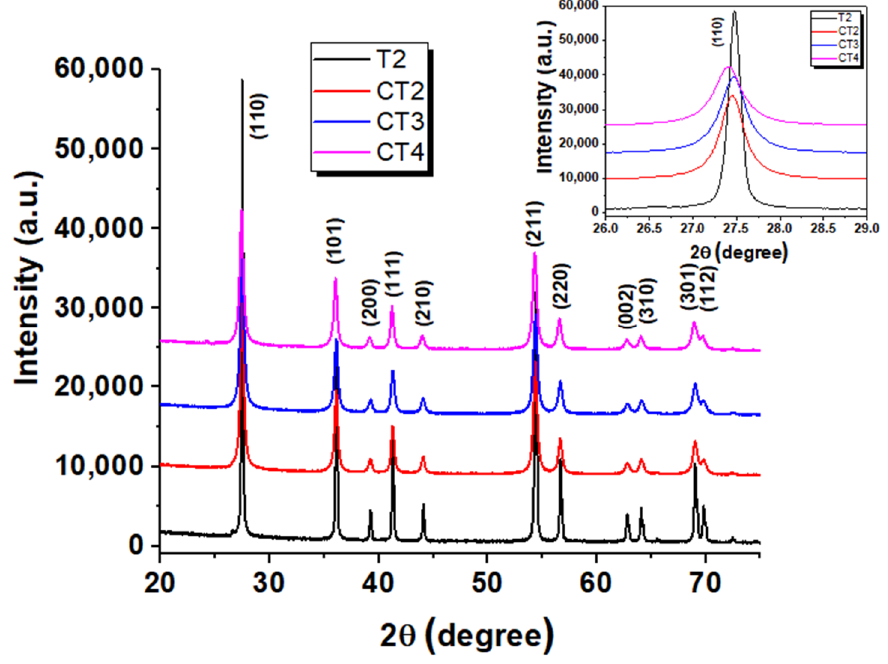
Figure 1. XRD diffraction profiles of pure TiO 2 (T2) and Cu (0.5, 1, 2%)-doped TiO 2 (CT2-CT4) Figure 1. composites. Table 1. The values of the lattice parameters (crystallographic planes ( d hkl ), the average crystallite Table 1. The values of the lattice parameters (crystallographic planes ( d hkl ), the average crystallite size (D, nm), unit cell parameters ( a , c , Å ), Ti-O-Ti bond length (L, nm), and the micro-deformation size (D, nm), unit cell parameters ( a , c , Å), Ti-O-Ti bond length (L, nm), and the micro-deformation (ε, %)) and volume (V, Å 3 ) of pure TiO 2 and Cu-doped TiO 2 nanostructures. ( ε , %)) and volume (V, Å 3 ) of pure TiO 2 and Cu-doped TiO 2 nanostructures.